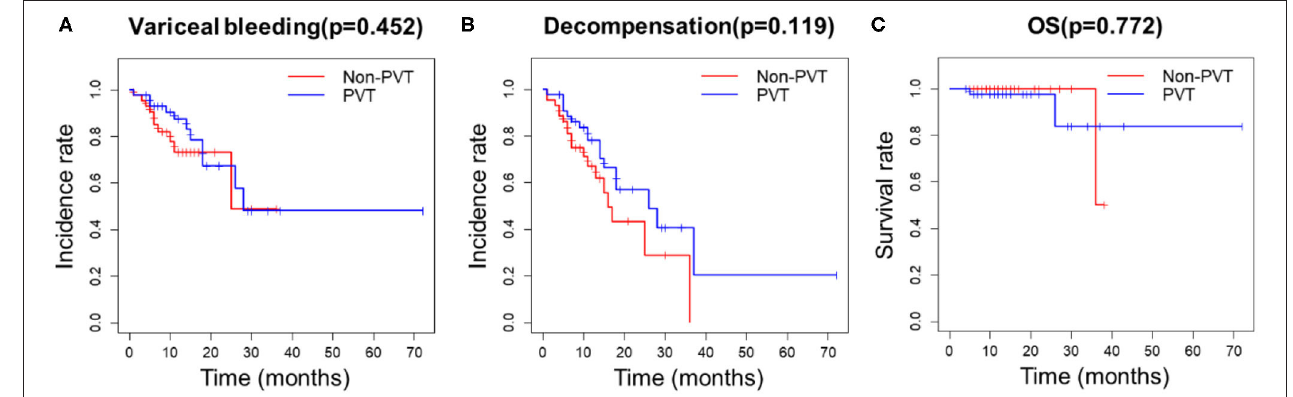
FIGURE 1 | Kaplan-Meier curves for PVT and non-PVT groups. (A) PVT had no effect on variceal bleeding, (B) decompensation of cirrhosis and (C) survival after PSM.